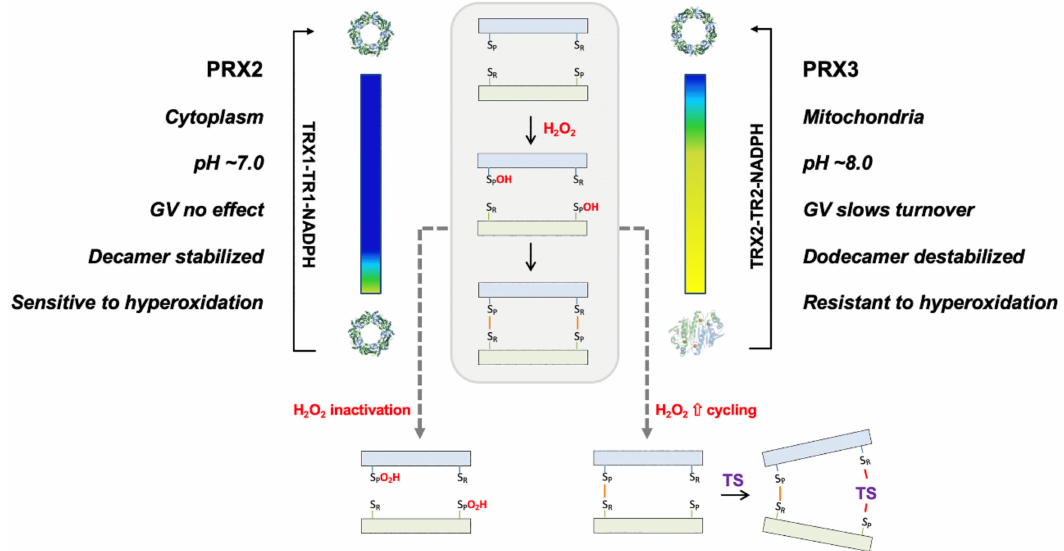
Figure 8. Summary of the biochemical, structural and environmental conditions that determine the specificity of TS for PRX3. The PRX3 dodecamer (blue) readily collapses to dimer (yellow; same coloring scheme used as in Figure 5), while the PRX2 decamer is more stable. In contrast to PRX2 where an increase in H 2 O 2 cycling leads to hyperoxidation and inactivation, PRX3 can form an asymmetric dimer with one disulfide present. The other active site can then react with TS to form a covalent crosslink. Treatment with GV slows the reduction of the disulfide, further enhancing the formation of TS adducts. Double TS adducts have been observed with recombinant